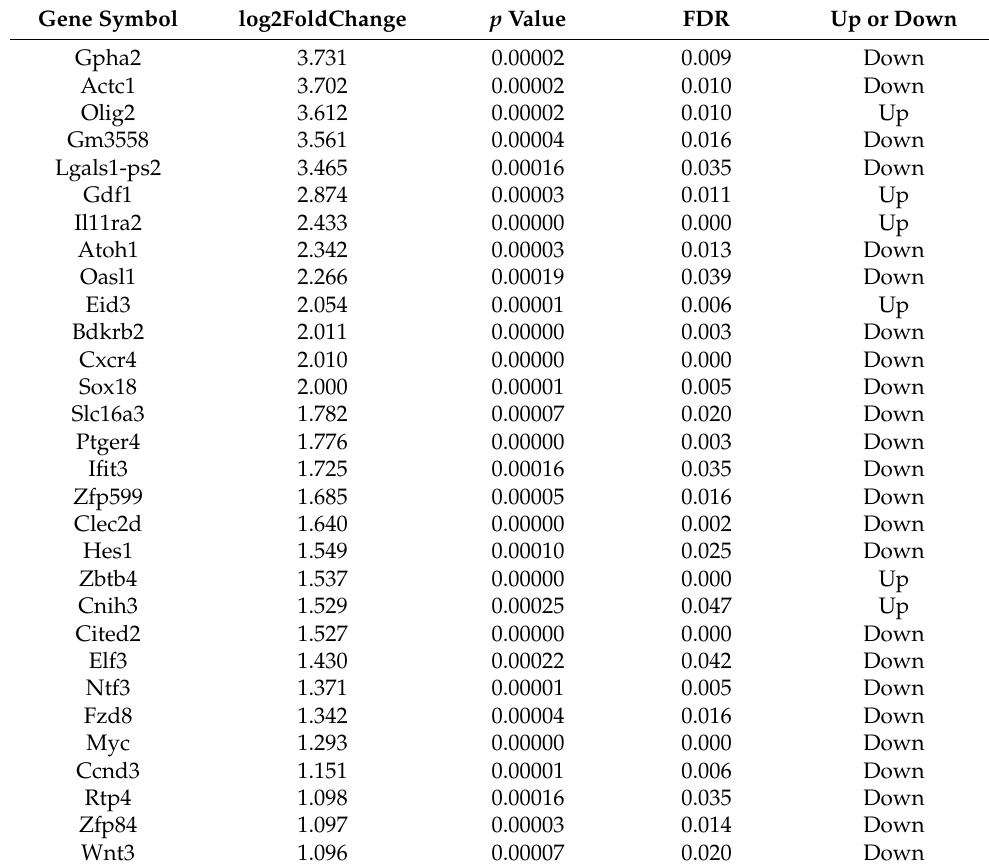
Table 2. Top 30 up- or downregulated